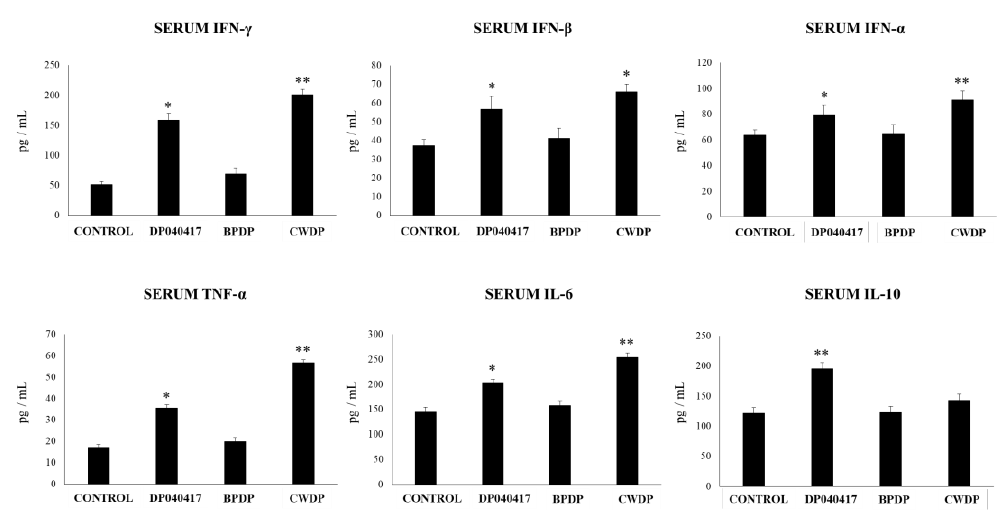
Figure 4. Effect of Dolosigranulum pigrum 040417 on blood cytokines. Viable (DP), bacterium-like particles (BPDP), or cell wall (CWDP) from D. pigrum 040417 were nasally administered to infant mice during five consecutive days. Non-treated infant mice were used as controls. Levels of tumor necrosis factor (TNF)- α, interferon (IFN) - α, IFN - β, IFN - γ, interleukin (IL) -6, and IL-10 were determined in serum one day after the last treatment. Experiments were performed with 5 – 6 mice per group. The results represent data from three independent experiments. Significantly different when compared to control * p < 0.05 or ** p < 0.01.